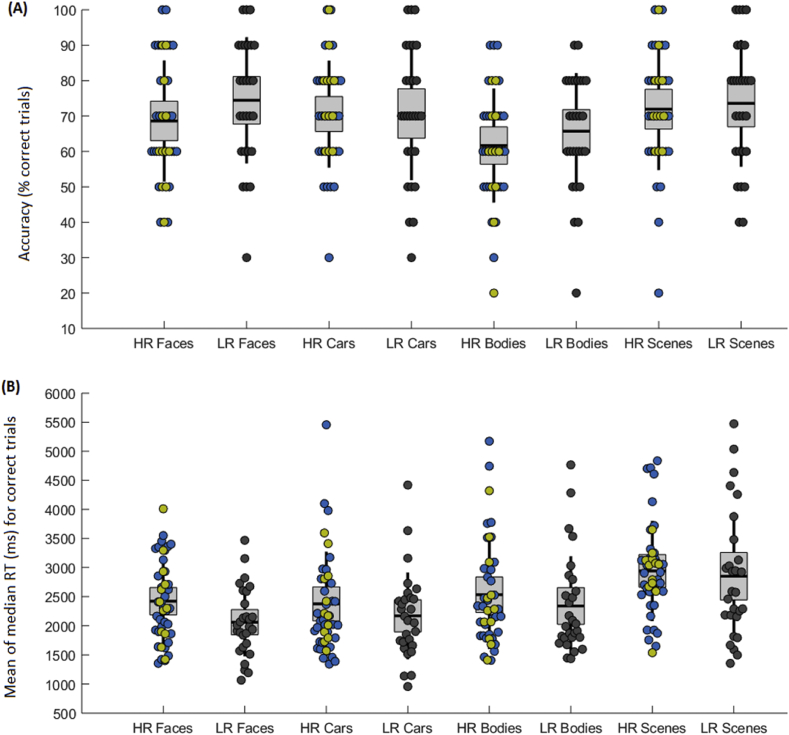
Performance in the face recognition task in mid-childhood. Boxplots display the group means (black line) and individual participants' scores (circles) for accuracy and RT performance in the face recognition task in mid-childhood. Panel (A) shows accuracy performance (% correct trials per condition) and Panel B shows the mean-of median RT for correctly recognised trials (ms). HR and LR group means and individual scores are presented in separate columns. Children in the LR group are indicated by grey circles; children in the HR group are indicated by blue circles, with the HR children who met diagnostic criteria for ASD highlighted in yellow.